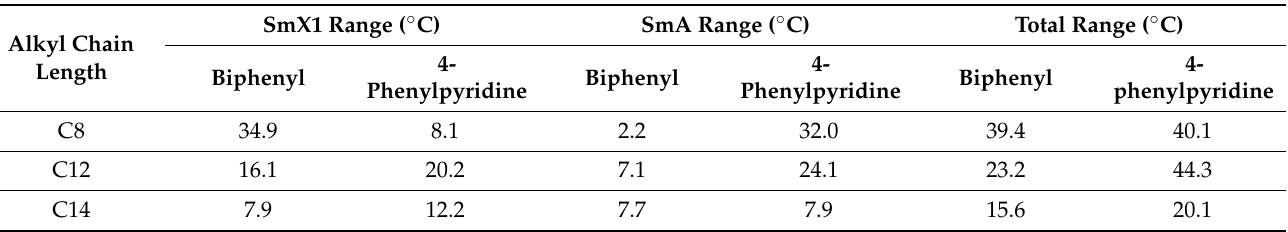
Table 2. Variation of mesophase temperature ranges of the different observed textures for the mesomorphic compounds bearing the biphenyl group rather than 4-phenyl pyridine ends in their mesogens. SmX1 and SmA were identified by the authors in [40] for samples 3.c , 3.d and 3.e as SmX1 and SmA, respectively. Alkyl Chain